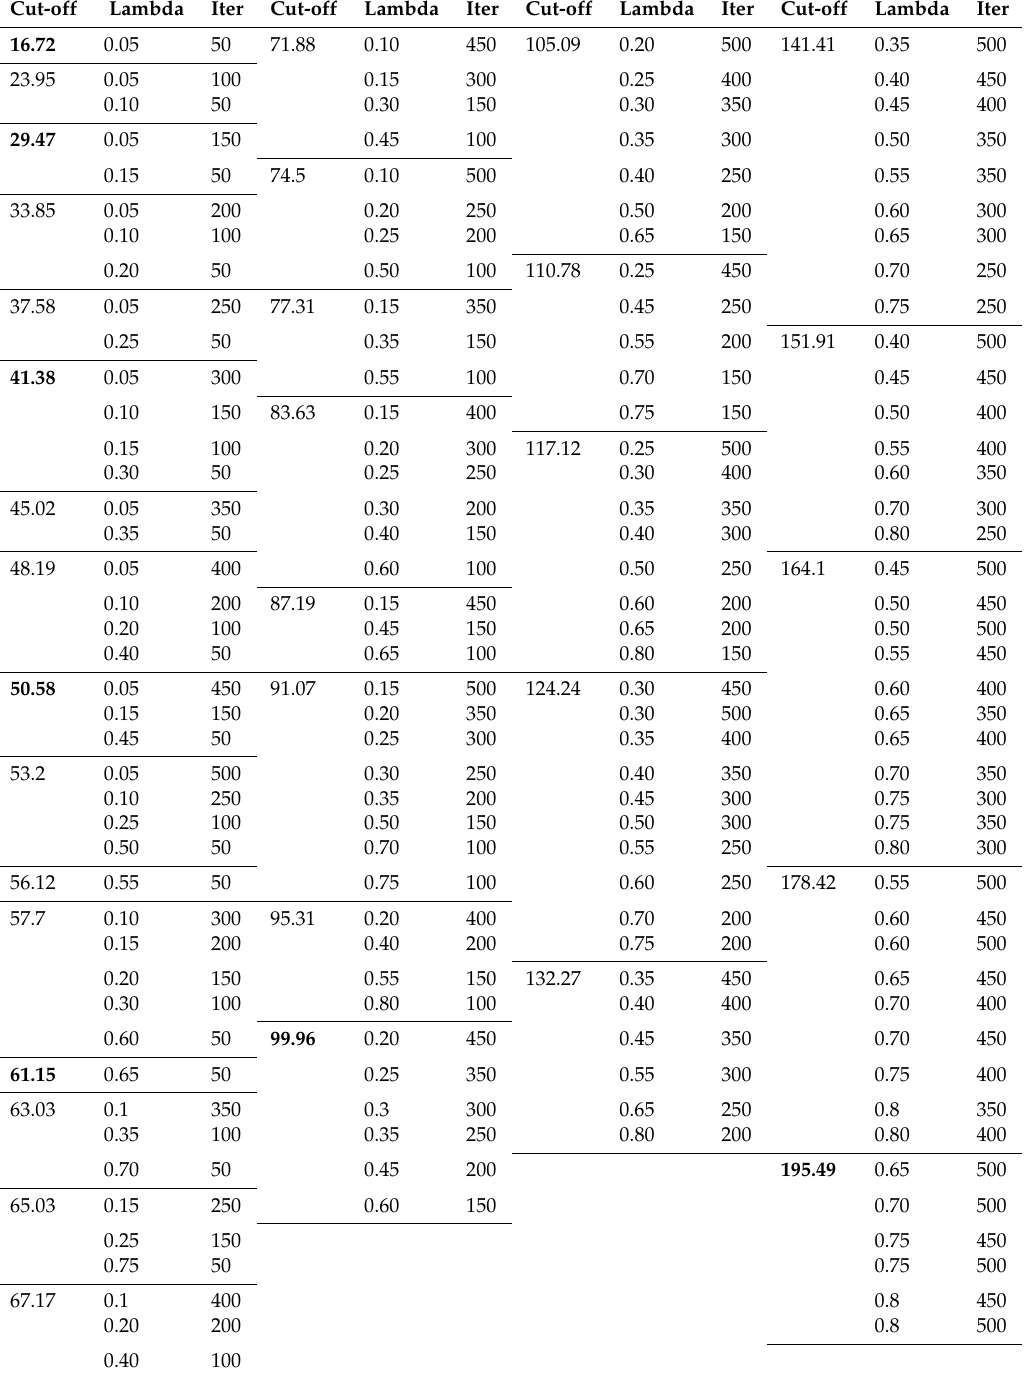
Table A1. Cut-off wavelengths ( λ c ) values and their corresponding lambda and number of iterations (iter) combinations. The cut-off wavelengths shown in Figures 7–12 are in bold.